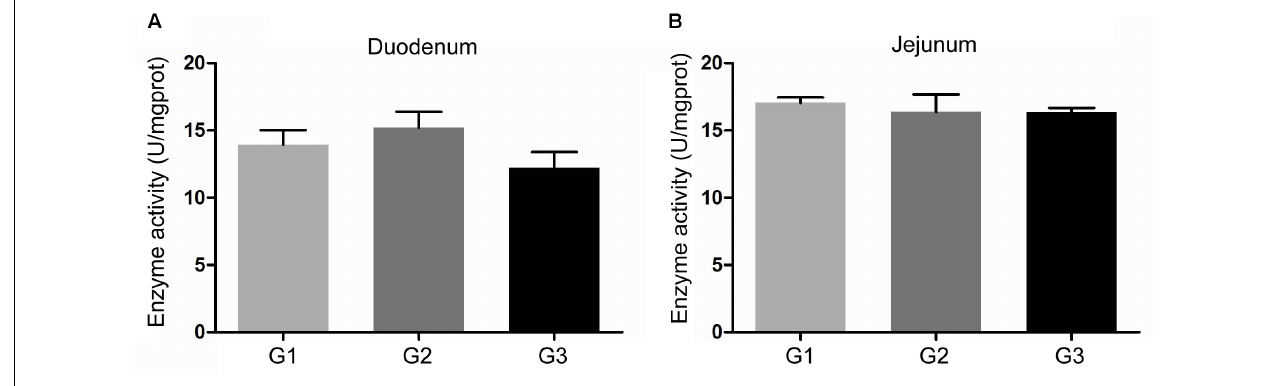
FIGURE 5 | Effects of Ba on the activity of sucrase (A) , lactase (B) , maltase (C) , AKPase (D) , Na + , K + -ATPase (E) , γ -GT (F) , and DAO (G) in jejunal mucosa of piglets. Results were expressed as mean ± SEM, n = 6. a and b means significantly different ( p < 0.05).